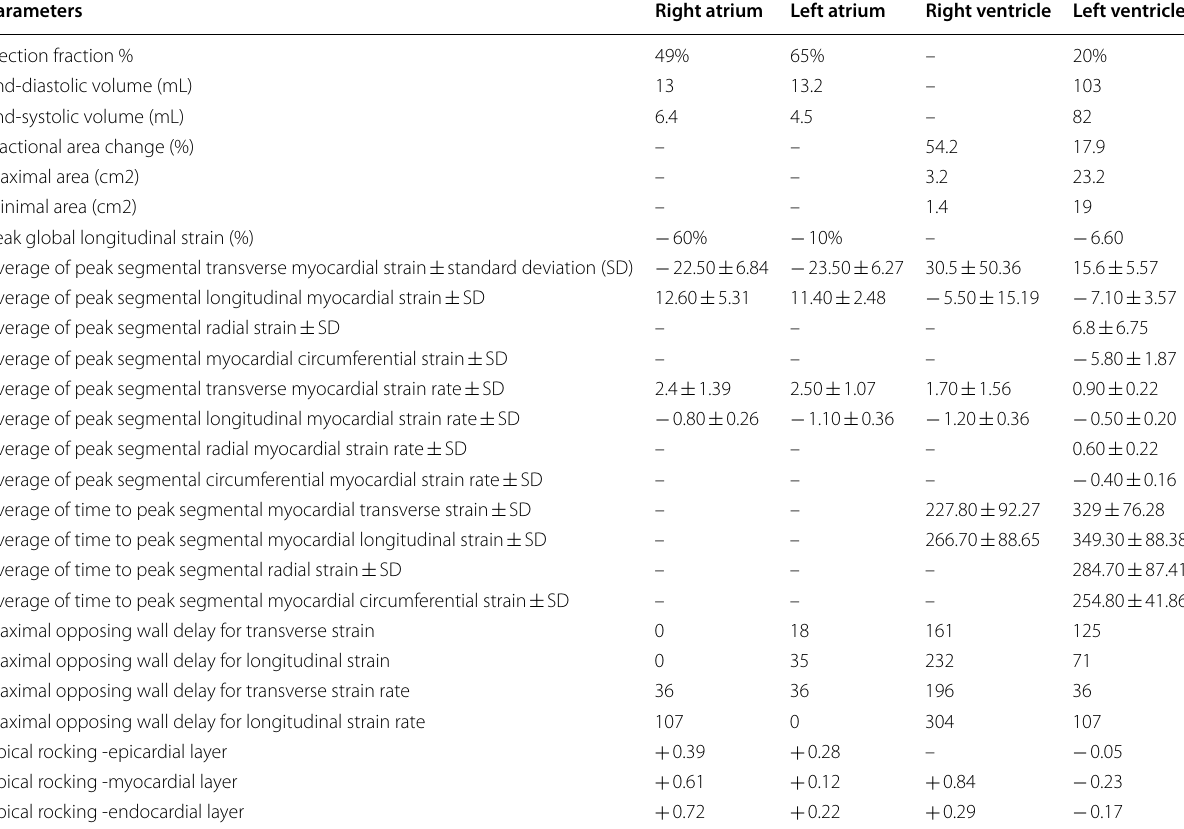
Table 1 Results of speckle-tracking strain imaging of the atria and ventricles